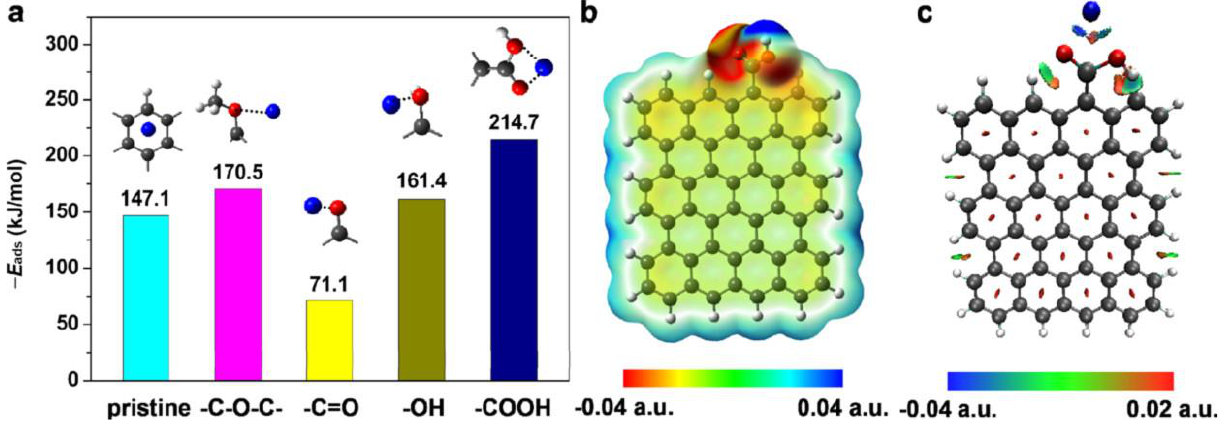
Figure 5. ( a ) Adsorption energy of Na on the pristine carbon surface and near ether, ketone, hydroxyl, as well as carboxyl. ( b ) Electrostatic potential mappings of the carbon surface modified with carboxyl; ( c ) BLYP/DEF2-SVP gradient iso surfaces with s = 0.5 au for the adsorption complexes (Copyright and permission, ACS Sustainable Chem. Eng — 2022).